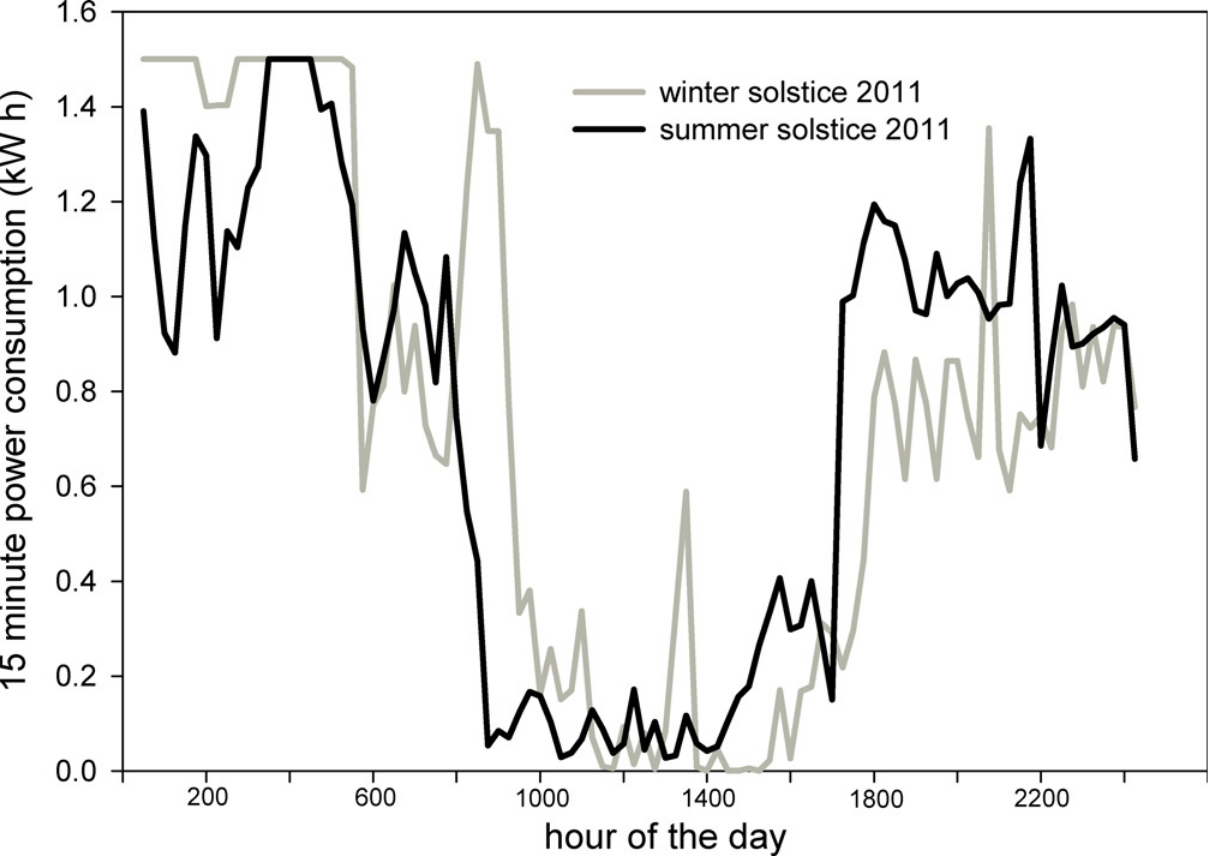
Figure 4. Daily variation in power use in an IR warmed, T-FACE experimental plot. Power consumption during 15 minute periods for one 6-IR-heater T-FACE plot during the 24 hours on the summer and winter solstice of 2011 at the Prairie Heating and CO 2 Enrichment experiment. Flat lines near 1.5 kWh show maximum electricity